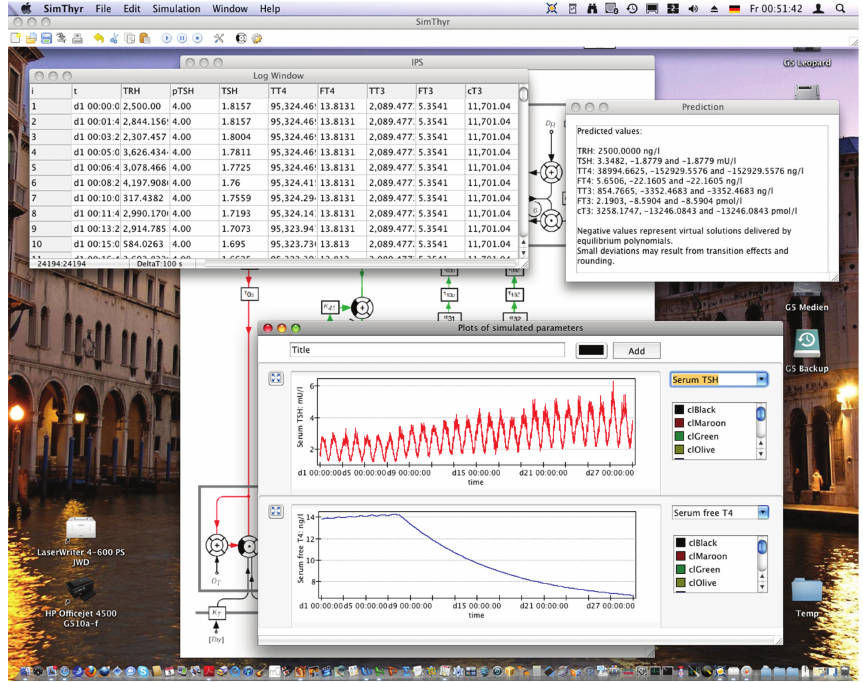
Figure 3: SimThyr, a continuous simulation program for thyrotropic feedback control